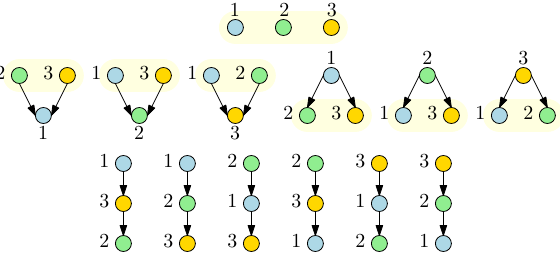
Figure 3. Possible combinations in the hierarchical leadership design for three decision-makers. Ordered Bell number B ( 3 ) = 13.